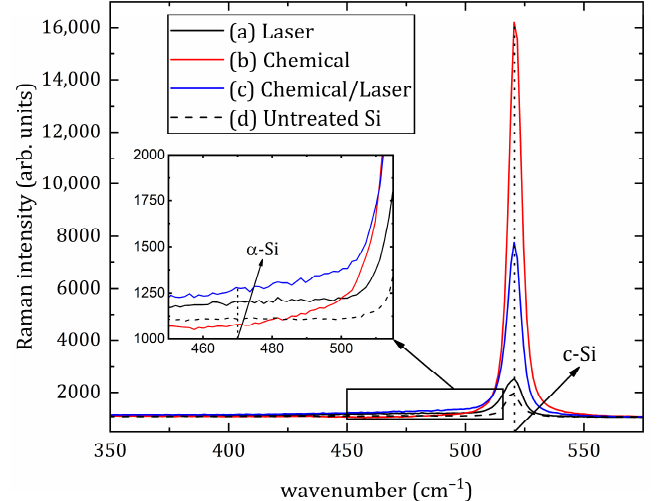
Figure 3. Raman spectra of silicon surface: ( a ) Sample #1—laser texturing of a silicon cut; ( b ) Sample #2—chemical etching; ( c ) Sample #3—hybrid chemical/laser fabrication; ( d ) Untreated Si.